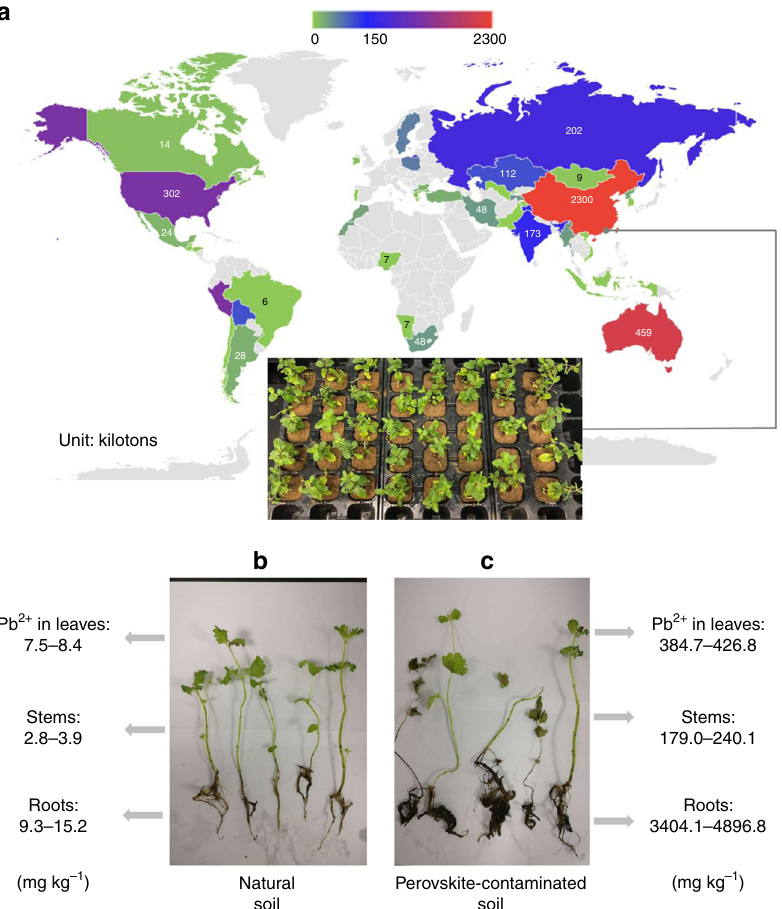
Fig. 1 Overview of the experiment of plants grown in perovskite-contaminated soils. a Distribution of lead production worldwide in 2017 (open data from British Geological Survey 16 ). The inset shows the photo of mint plants grown in perovskite-contaminated soil within the campus of Fujian Agriculture and Forestry University, China (latitude 26.084, longitude 119.238). b The picture of mint plants grown on control soil (left) and c 250 mg kg − 1 Pb 2 + perovskite-contaminated soil (right). The range of lead content measured in the leaves, stem, and root is reported on the side of each